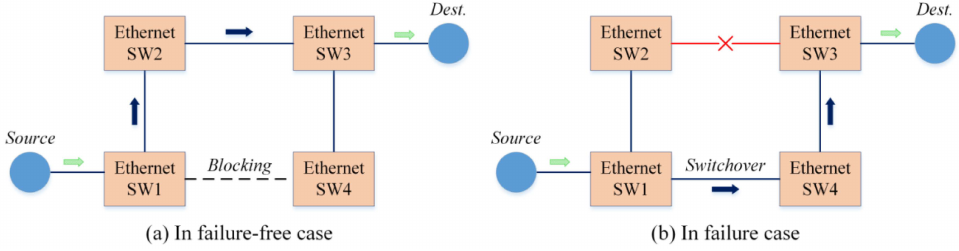
Figure 16. Redundancy provided by RSTP.